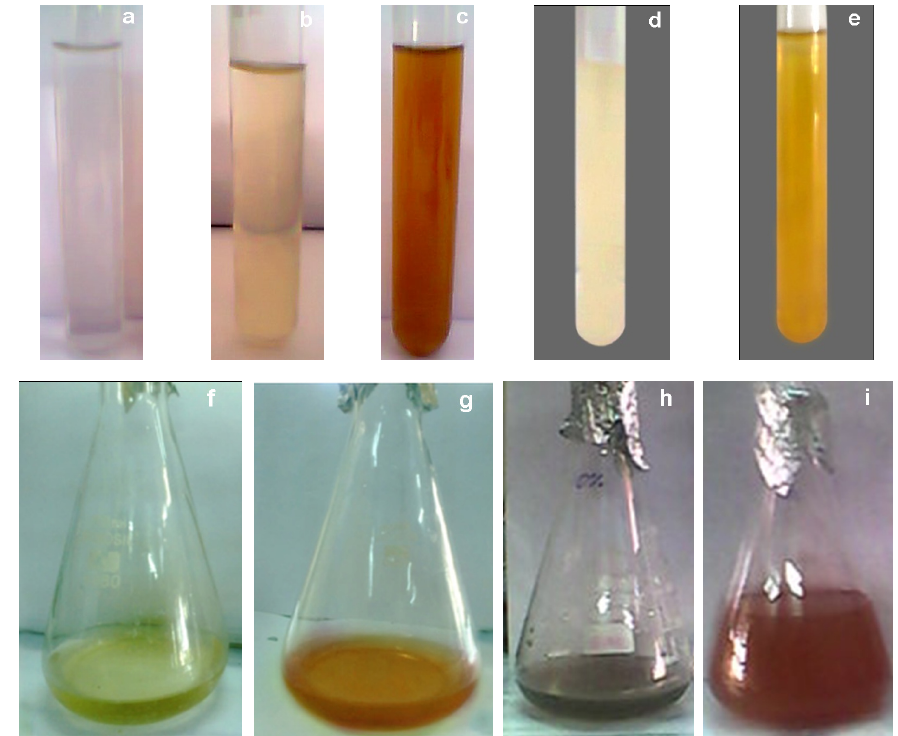
Fig. 1. Optical photograph of a) AgNO g) GL+AgNo